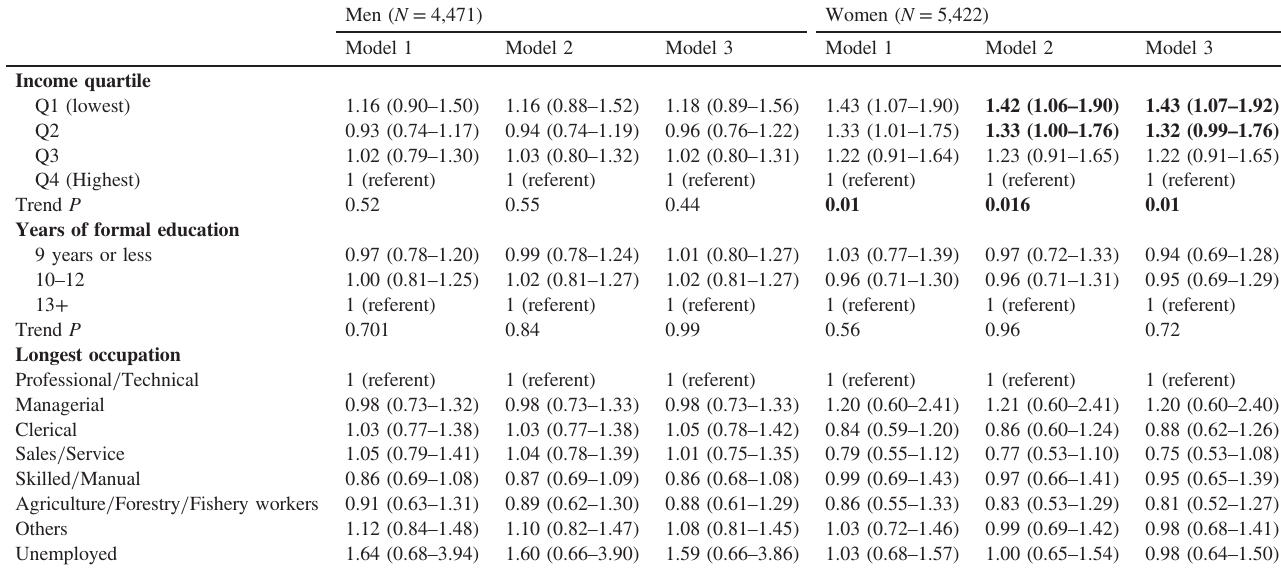
Table 3. Prevalence ratios and 95% con fi dence intervals for diabetes mellitus by sex with multiple imputation ( N =